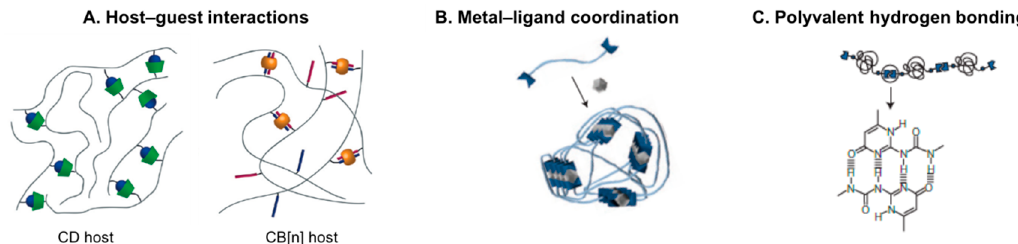
Figure 5. Supramolecular biomaterials formed by crosslinking of polymeric precursors through ( A ) host–guest complexation using macrocyclic hosts ( B ) coordination of metals with ligands (end-terminated or grafted on polymer chains), and ( C ) multiple hydrogen-bonding motifs. Reproduced with permissions from: (A) [11], copyright 2018, The Royal Society of Chemistry; (B) [135],